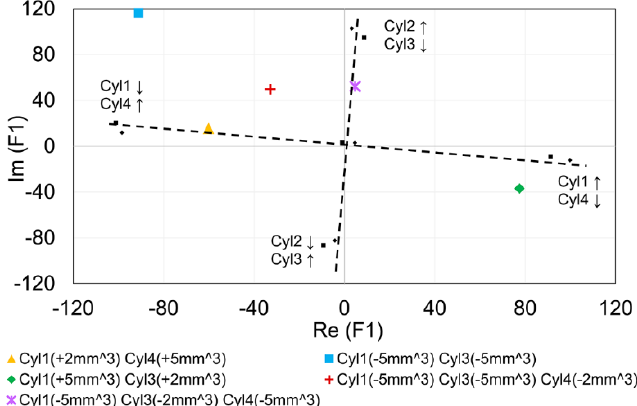
Figure13. RepresentationinthecomplexplanoftheF1orderat1500rpmandfullloadbysimultaneously Figure 13. Representation in the complex plan of the F1 order at 1500 rpm and full load by varying the injected fuel in two and three simultaneously varying the injected fuel in two and three cylinders.